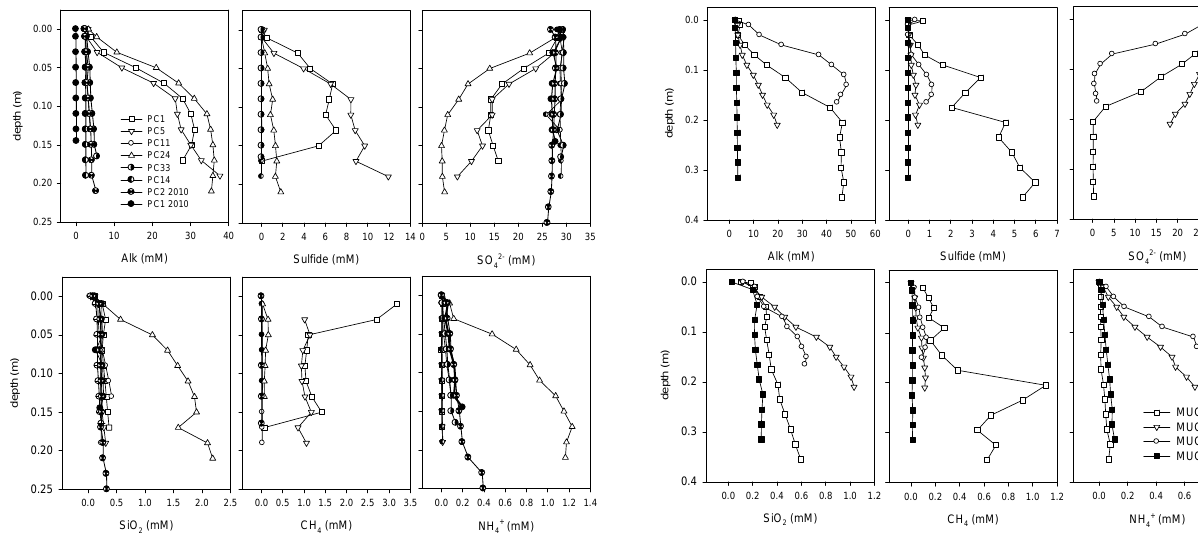
Fig. 3. Porewater chemistry profiles obtained from sediments re- trieved by the push cores (PC). The reference data, obtained from a core approximately 550m southwest of the vents, are indicated with black symbols. Other distances from the Abyss Vent: PC1 (1m), PC5 (1m), PC11 (10m), PC33 (0.5m), PC24 (2m), PC14 (10m), and PC1 2010 (100m).